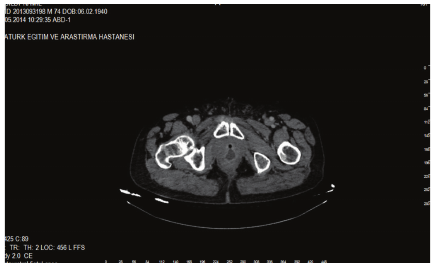
Figure 2: Rectum, urethra, and RUF are seen in tomographic